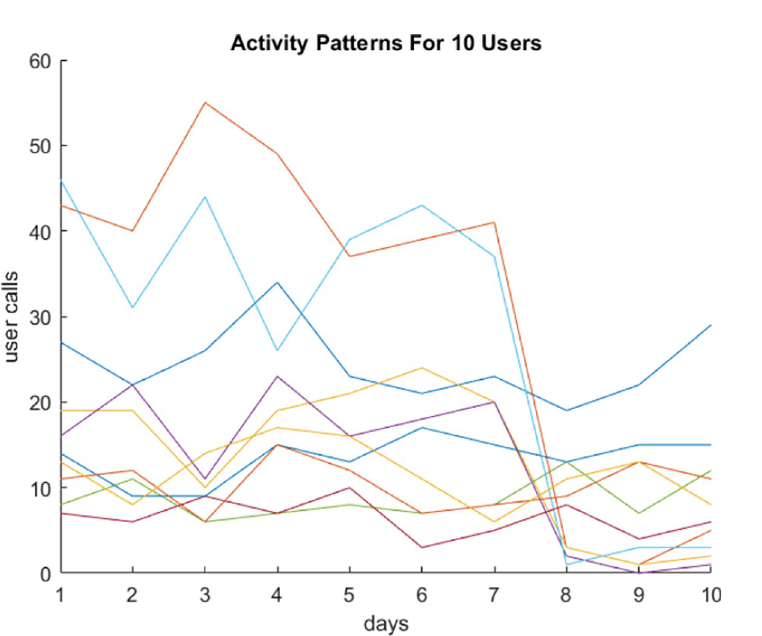
Fig 7. Plotting the activity of 10 users in the